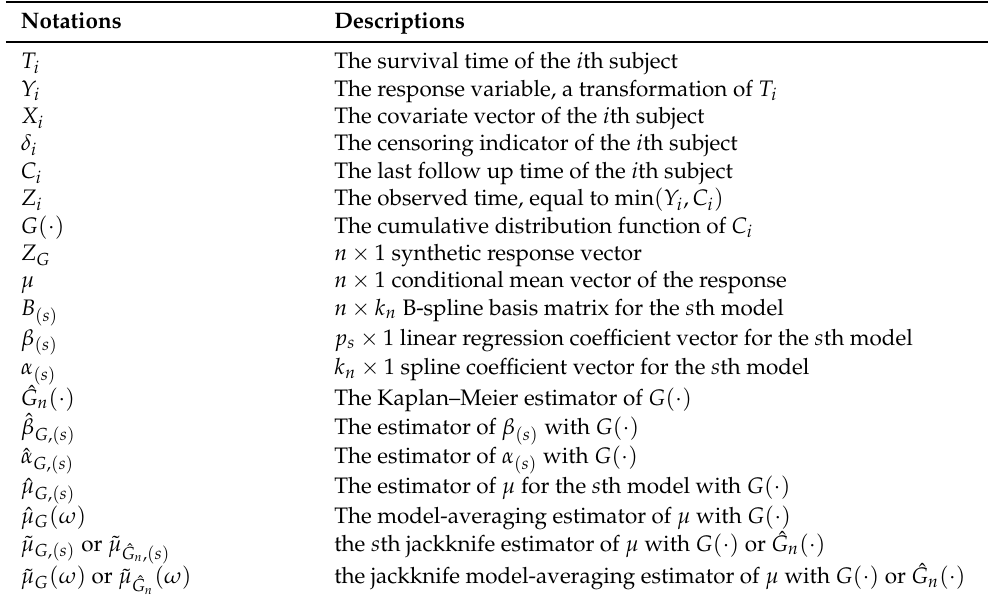
Table 1. The basic notations used in this